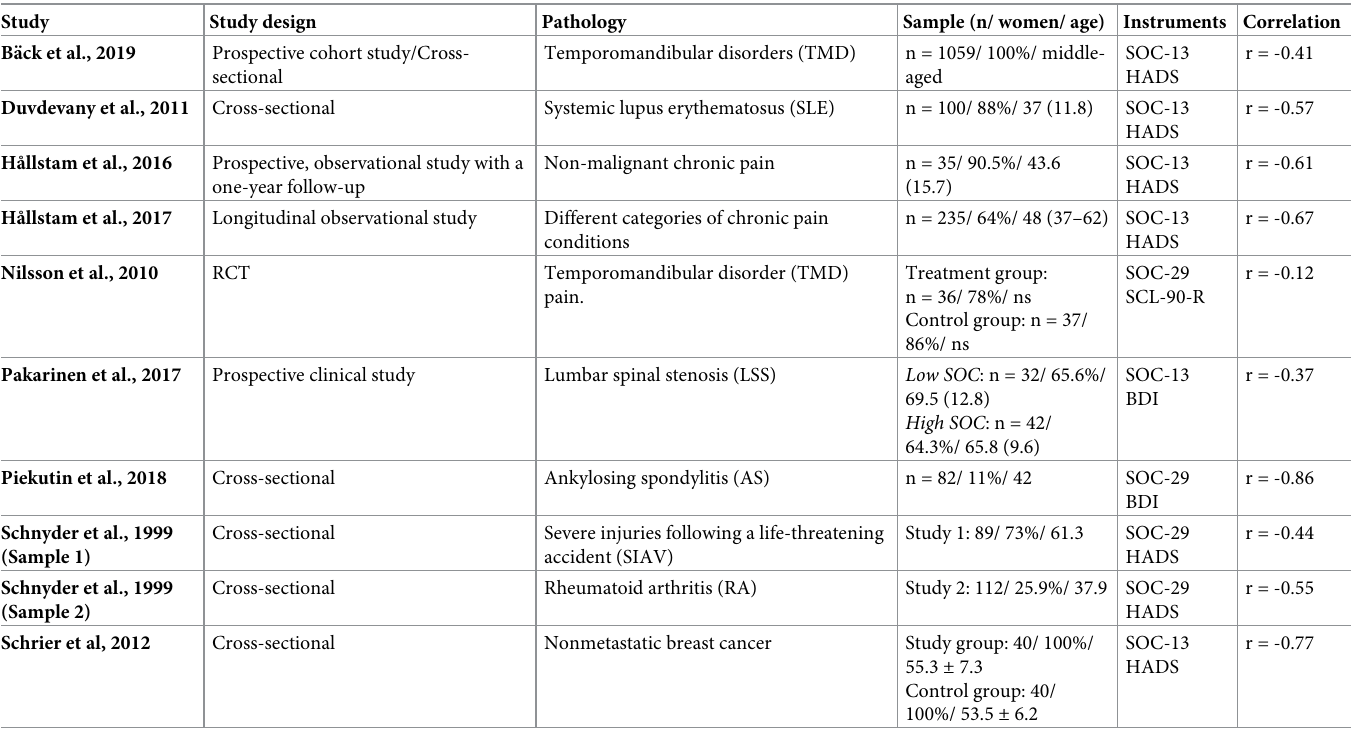
Table 2. Summary results from search